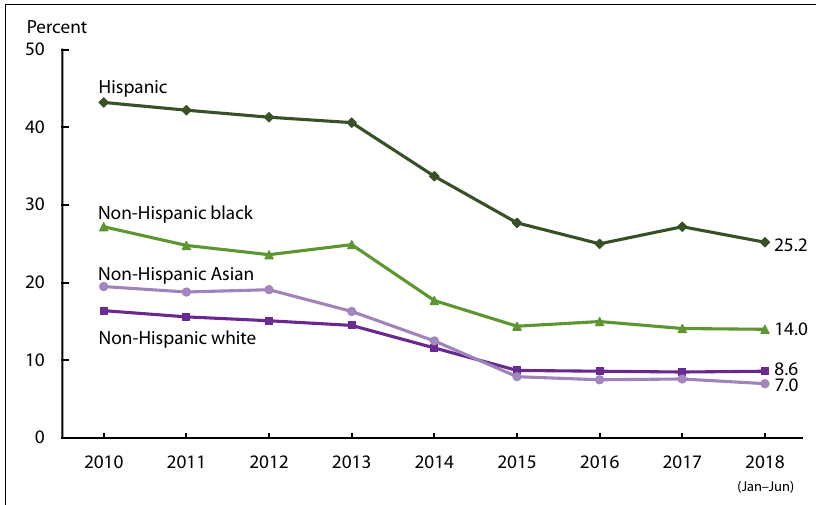
Figure 6. Percentage of adults aged 18 – 64 who were uninsured at the time of interview, by race and ethnicity: United States, 2010–June 2018